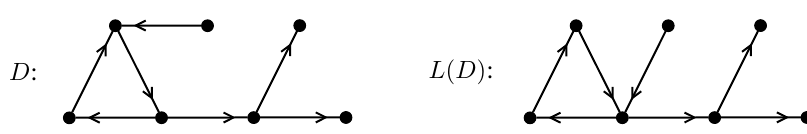
Figure 21: The foundation of the line digraph of an eddy digraph.